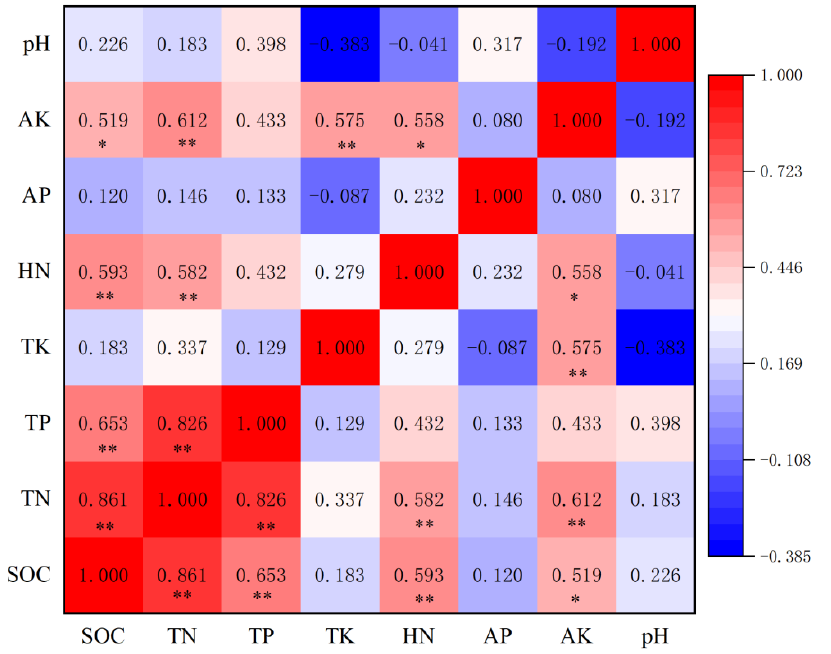
Figure 5. Pearson’s correlation heatmap of rhizosphere soil nutrient concentrations and pH: * Significant at p < 0.05; ** significant at p < 0.01.